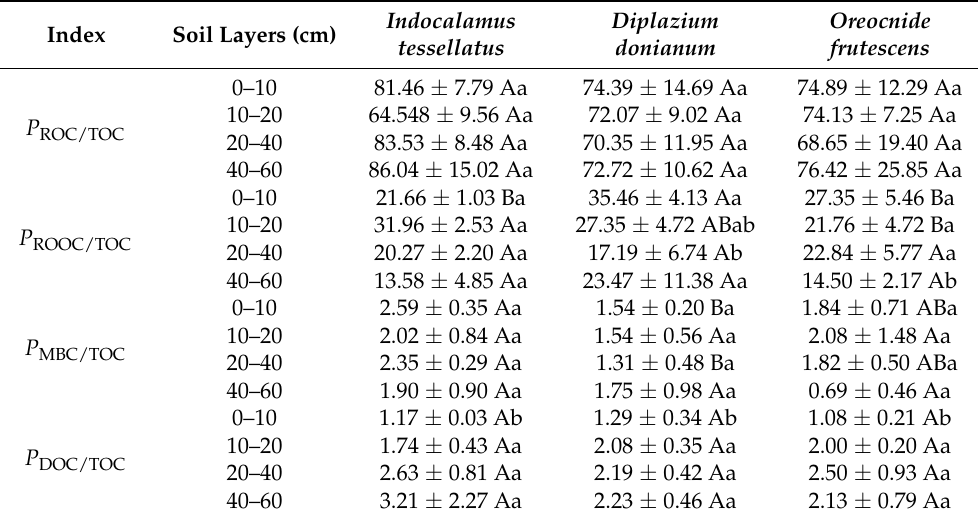
Table 2. Proportions of mass fraction of each soil organic carbon component to TOC